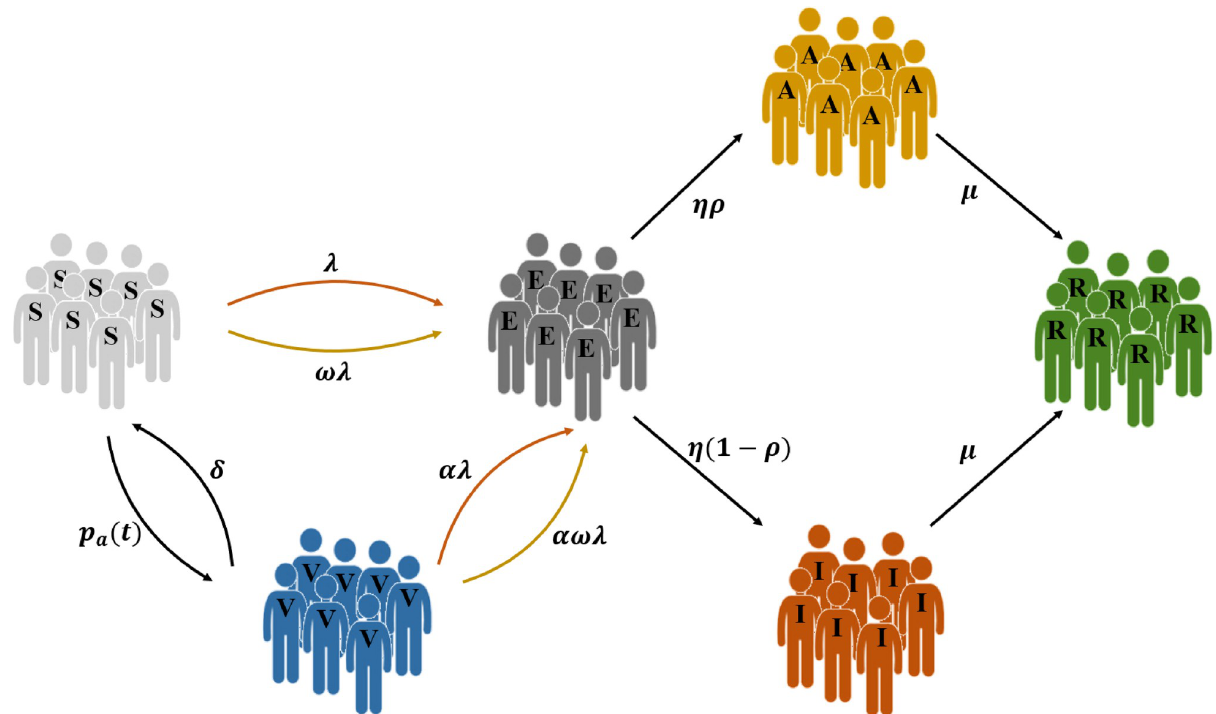
Fig 1. Schematic representation of the SEVAIR model. The arrows indicate the transition probabilities. Susceptible (S) individuals take vaccines with probability p a ( t ), and the susceptible (S) individuals who do not vaccinate will turn to exposed (E) state at transmission rate λ ( ω λ ), when contacting with symptomatic (I) (asymptomatic (A)) individuals. Vaccinated (V) individuals return to the susceptible individuals (S) at rate δ , and will be infected by contacting symptomatic (I) (asymptomatic (A)) individuals with an infection rate α λ ( α ω λ ). After an incubation period 1 become infectious, while the ratio of asymptomatic individuals from exposed individuals is ρ with ρ 2 [0, 1]. Both the asymptomatic (A) individuals and infected (I) individuals recover at rate μ .